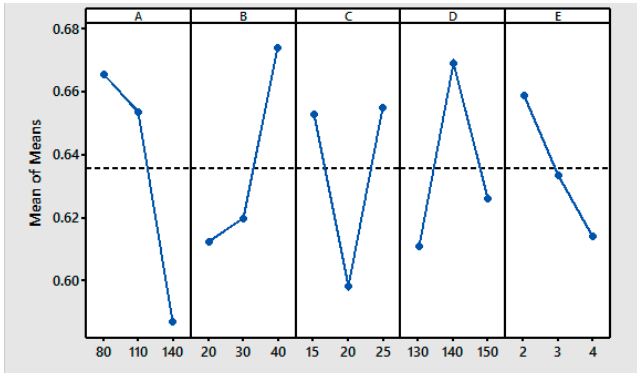
Figure 5. Main effect plots for the means [Response: GRG].